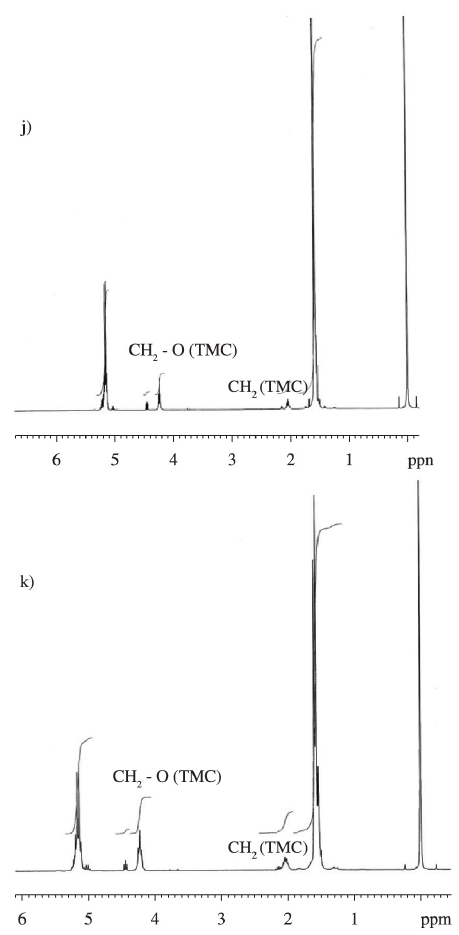
Figure 3. Comparison of the spectra for PLDLA-TMC obtained using 20% (spectrum j ) and 30% (spectrum k ) TMC. Note the enhanced proton peaks obtained with the higher concentration of TMC.